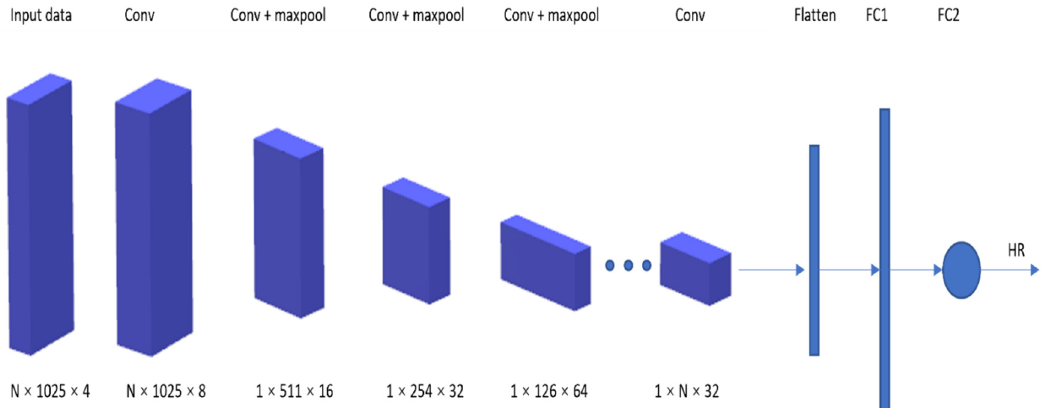
Figure 6. DeepPhys architecture.